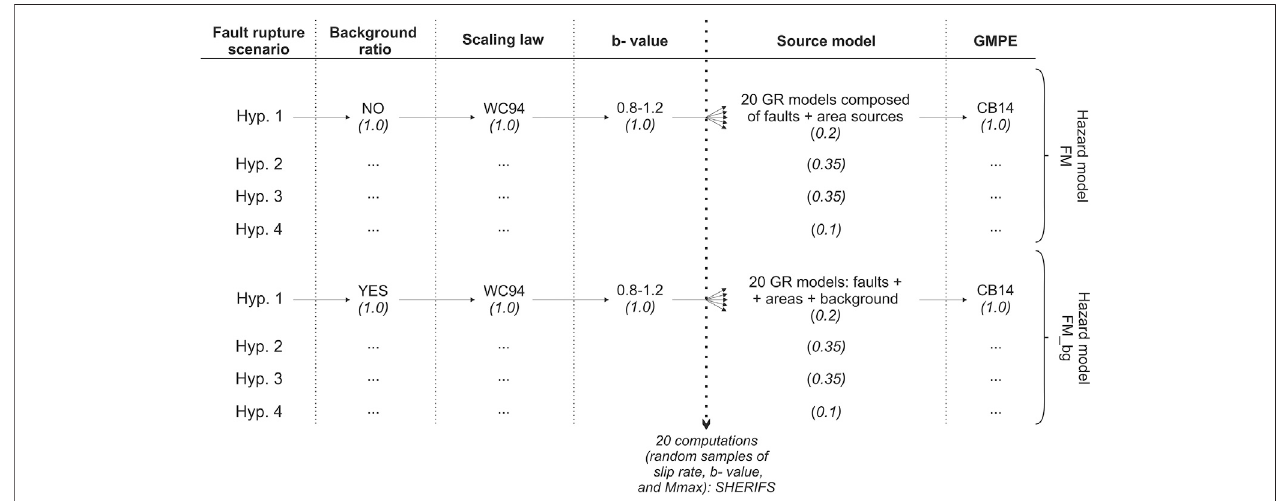
FIGURE 3 | Logic tree schemes followed in this study for both FM and FM_bg source models. The weights (over 1) of each branch in the logic tree are indicated in brackets. Hyp.: hypothesis; WC94: Wells and Coppersmith, 1994; CB14: Campbell and Bozorgnia, 2014.